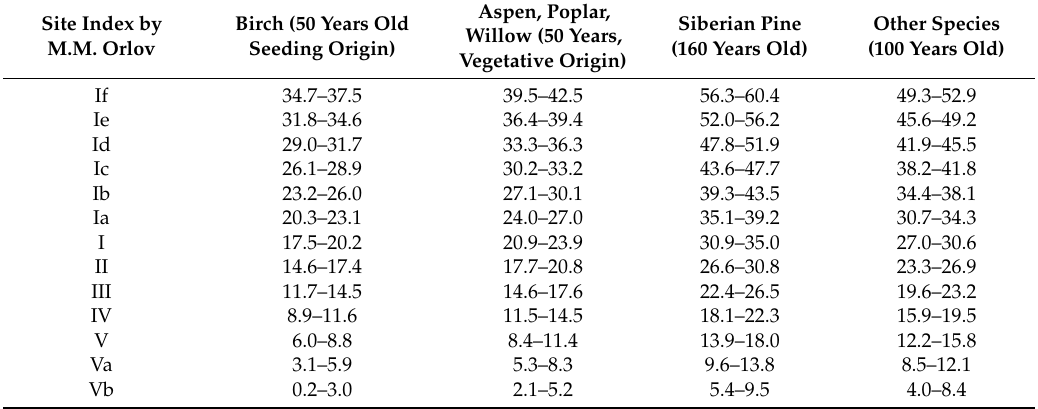
Table A1. Average stand height (m) for different Site Indexes [22] Equation (1).